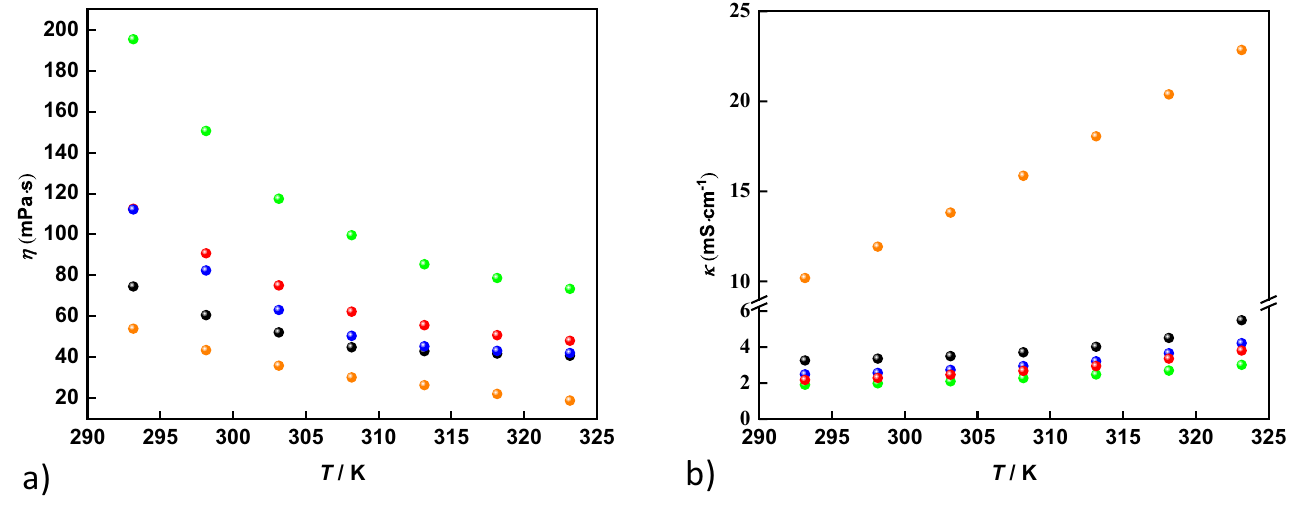
Figure 2. The temperature-dependent experimental viscosities ( a ) and electrical conductivities ( b ) for the investigated systems. Black – Li[TFSI] (1) :(C 2 OC 2 Pyr-C 2 OC 2 -C 2 OC 2 Pyr)[TFSI] 2(1) :H 2 O (3) ; red— Li[TFSI] (1) :(C 4 Pyr-C 2 OC 2 -C 4 Pyr)[TFSI] 2(1) :H 2 O (3) , blue – Li[TFSI] (1) :(C 2 OC 2 Pip-C 2 OC 2 -C 2 OC 2 Pip) [TFSI] 2(1) :H 2 O (3) ; green—Li[TFSI] (1) :(C 4 Pip-C 2 OC 2 -C 4 Pip)[TFSI] 2(1) :H 2 O (3) ; orange—Li[TFSI] (1) :H 2 O (3) .